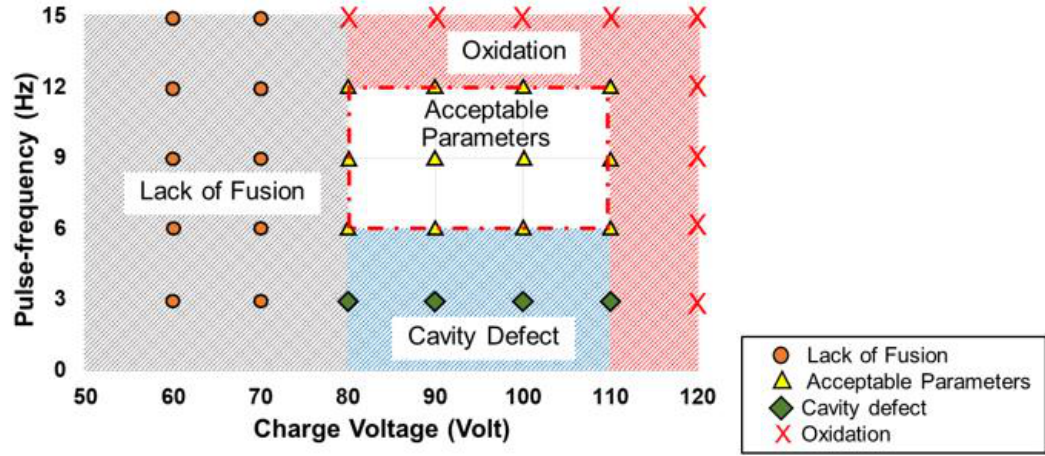
Figure 6. Inspection weld appearance of laser parameters. Table 1. Laser welding parameters.